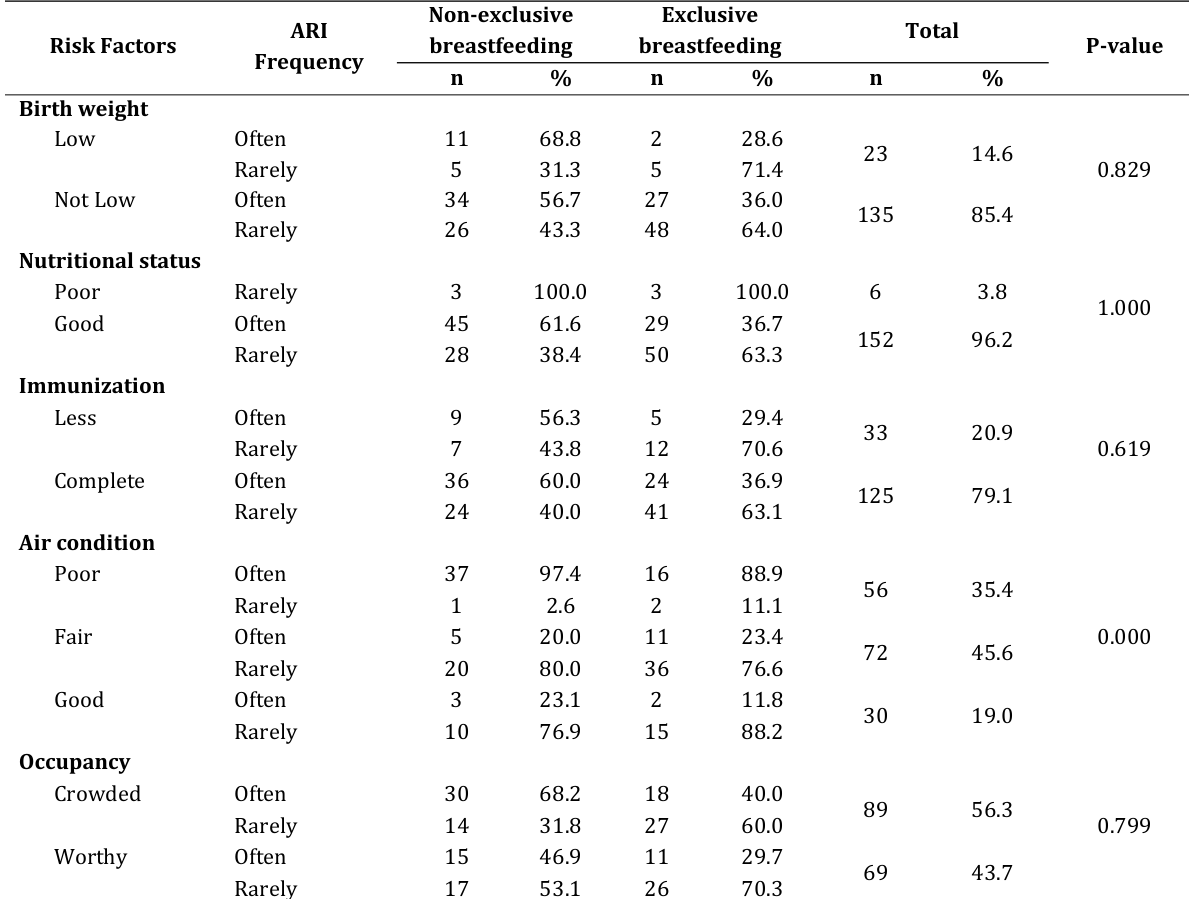
Table 2. Risk factors of ARI in non-exclusively and exclusively breastfed toddlers (N=158) Risk